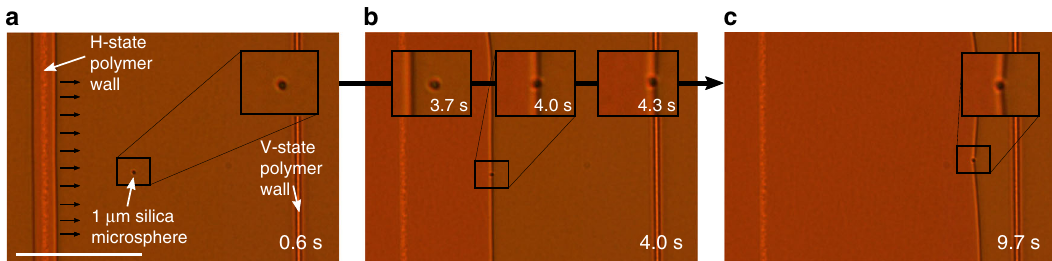
Fig. 3 Disclination line cargo-transport. a A 1 µ m silica microsphere is towed by a disclination line across the gap between topologically discontinuous polymer walls upon removal of a voltage V > V c at t = 0. b When the disclination line encounters the microparticle it c carries it across the channel to the polymer-stabilised V-state wall. Scale bar 50